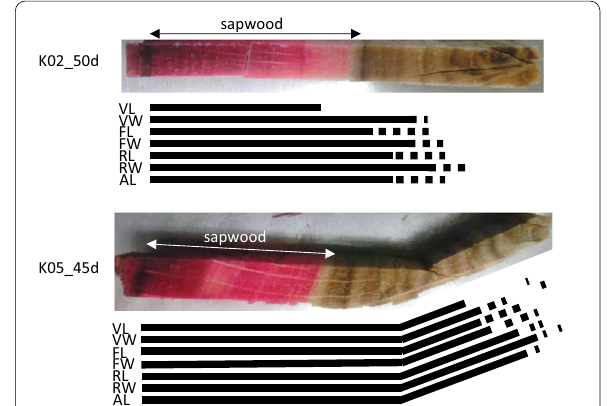
Fig. 3 Schematic representation of the radial distribution of cesium (Cs) in the xylem of normal konara oak ( Quercus serrata ) trees after long injection periods as observed using cryo-scanning electron microscopy/energy-dispersive X-ray spectroscopy (cryo-SEM/EDX).